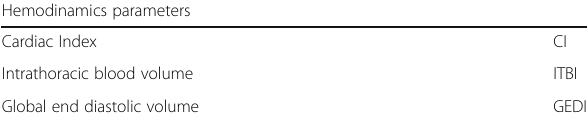
Table 1 (abstract 0301). See text for description.